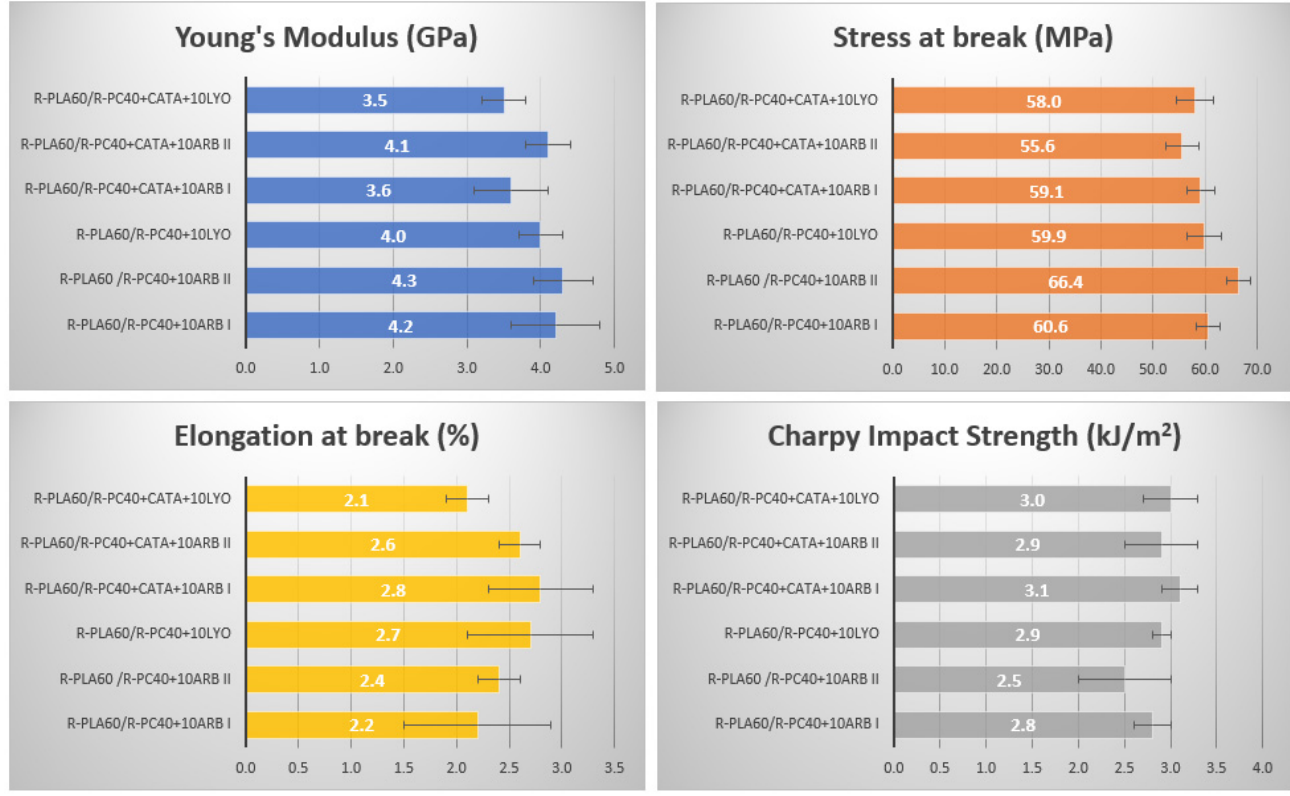
Figure 3. E’ and tan delta evaluation sweeping temperature for all the biocomposites produced. The black arrows represent tan delta peaks.